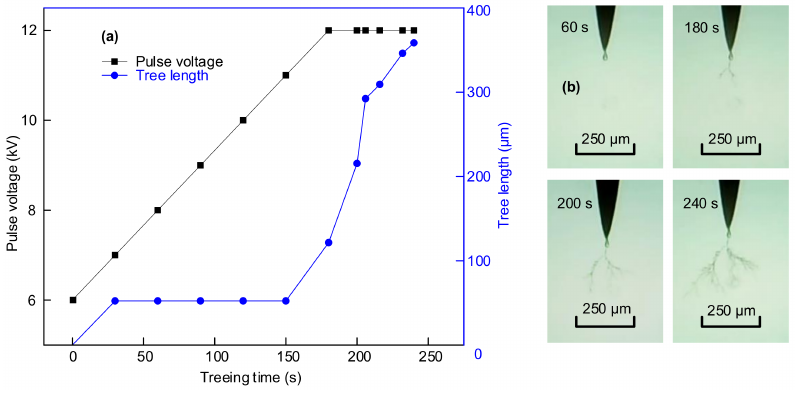
Figure 6. Growth process of bubble tree: ( a ) growth of tree length; ( b ) tree structure at different treeing